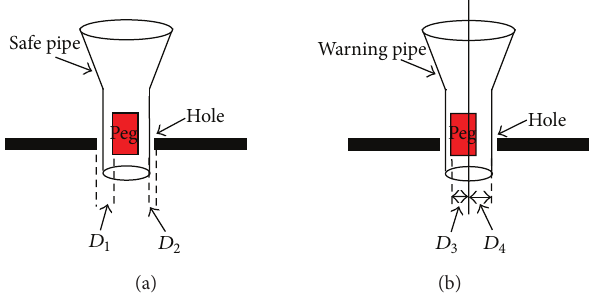
Figure 6: Definition of the distances. 𝐷 1 : the distance between the peg and the edge of the hole. 𝐷 2 : the distance between the pipe and the edge of the hole. 𝐷 3 : the sum of the radius of peg and the deviation of the peg from the reference path; 𝐷 4 : radius of the warning